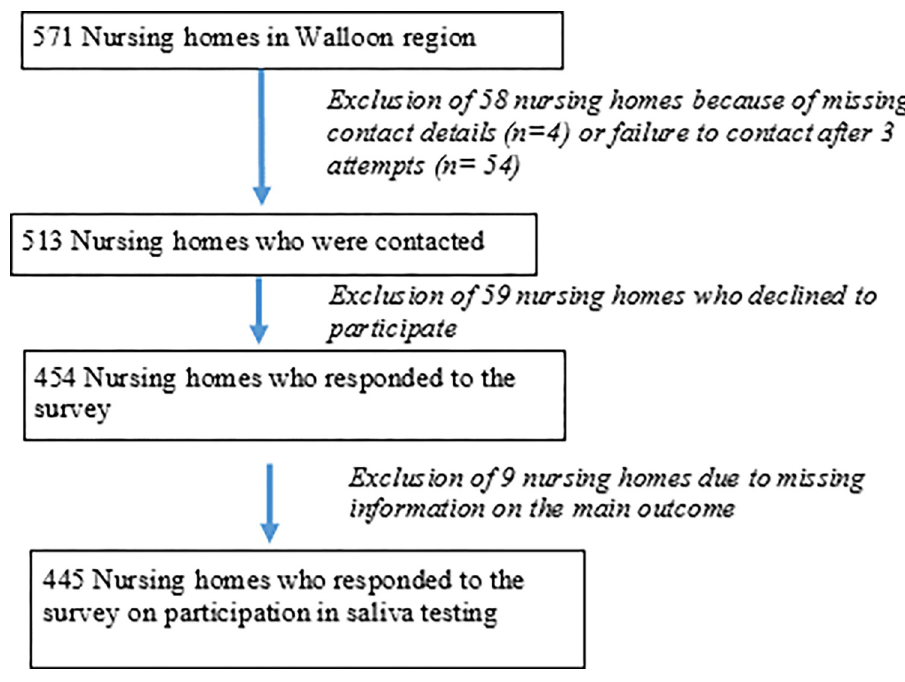
Fig 1. Flowchart of participation in the